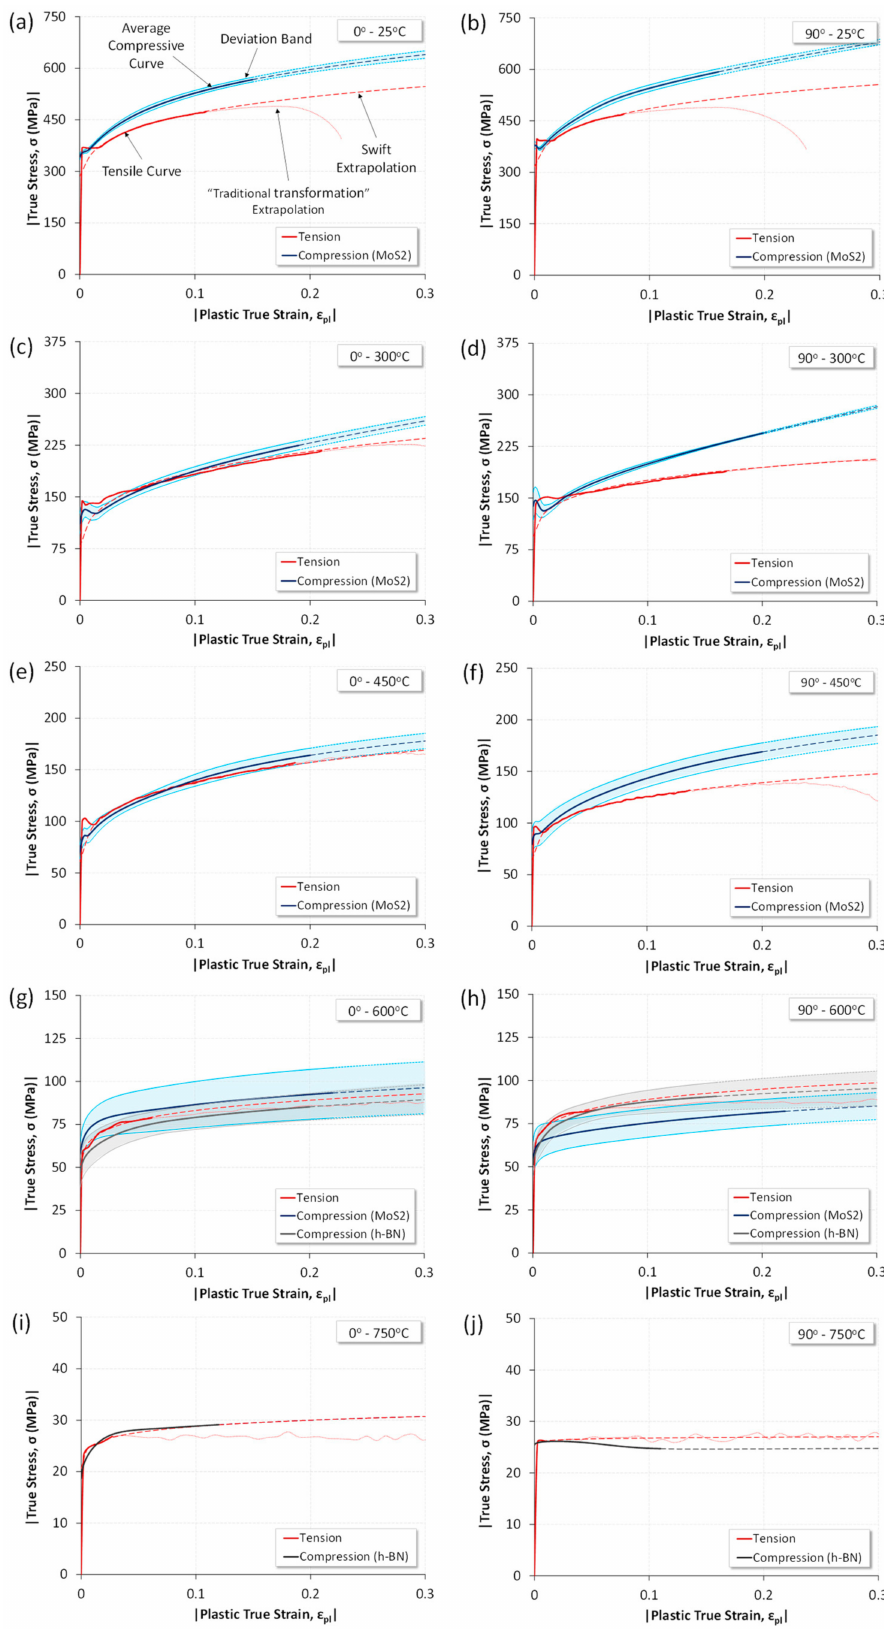
Figure 8. Tension and compression mechanical curves of Ticp2 at 0.002 s − 1 and temperatures of 25, 300, 450, 600, and 750 ◦ C. ( a , c , e , g , i ) Mechanical behavior in rolling direction (0 ◦ ); ( b , d , f , h , j ) Mechanical behavior in transverse direction (90 ◦